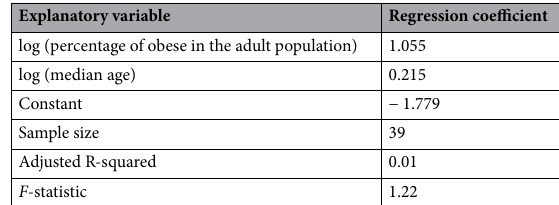
Table 4. COVID-19 Mortality and Proportion of obese in Adult Population: Upper Middle-Income Countries. Dependent variable is log of COVID-19 Mortality.